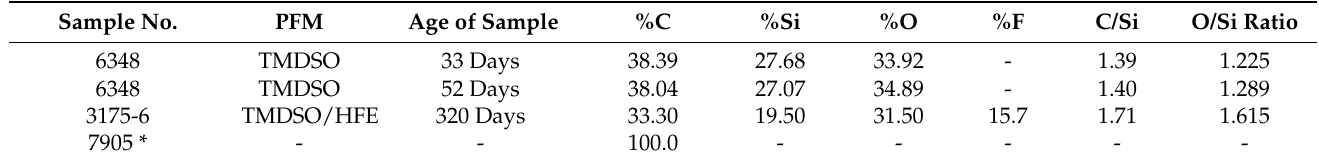
Table 13. Atomic concentrations in atomic percent of elements in the surface of TMDSO and F/Si plasma polymer coated X30-240 HFM.